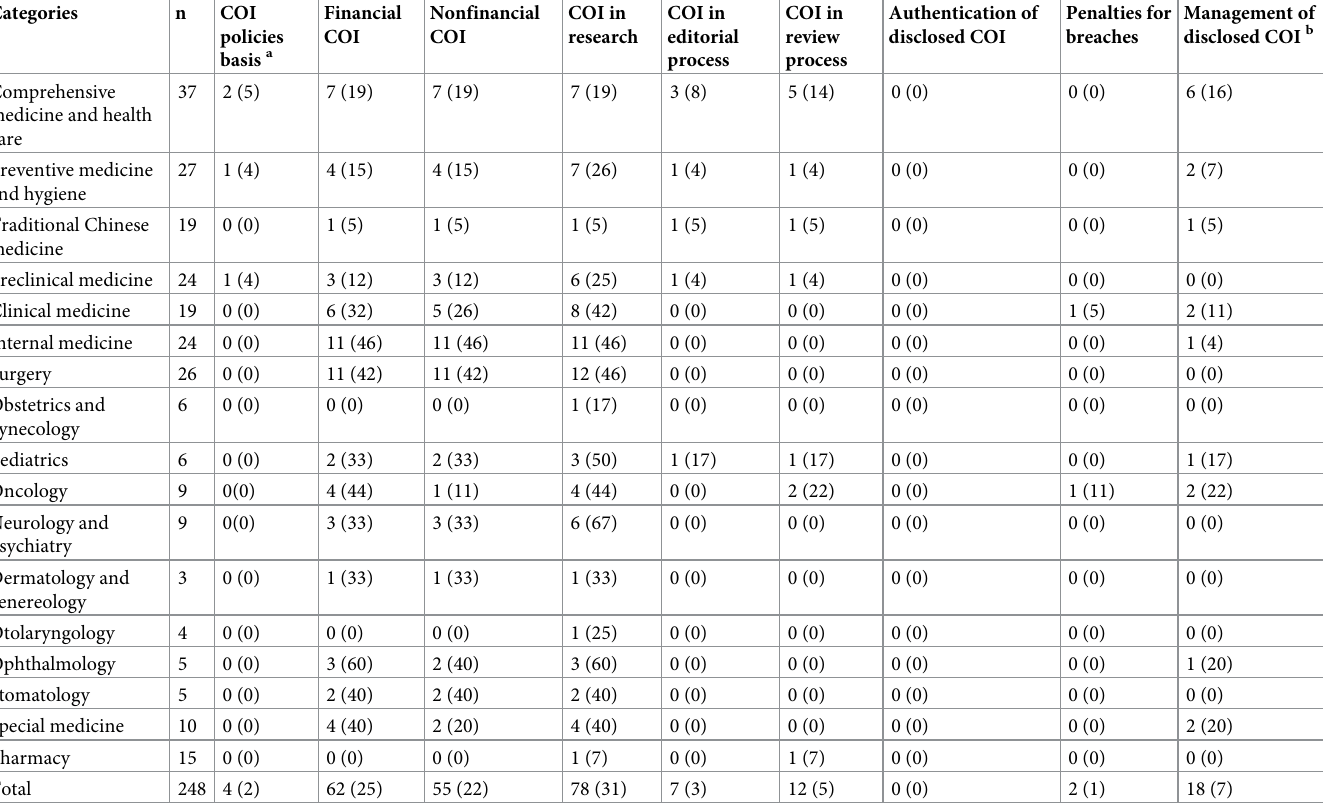
Table 2. Contents of COI policies among journals [n